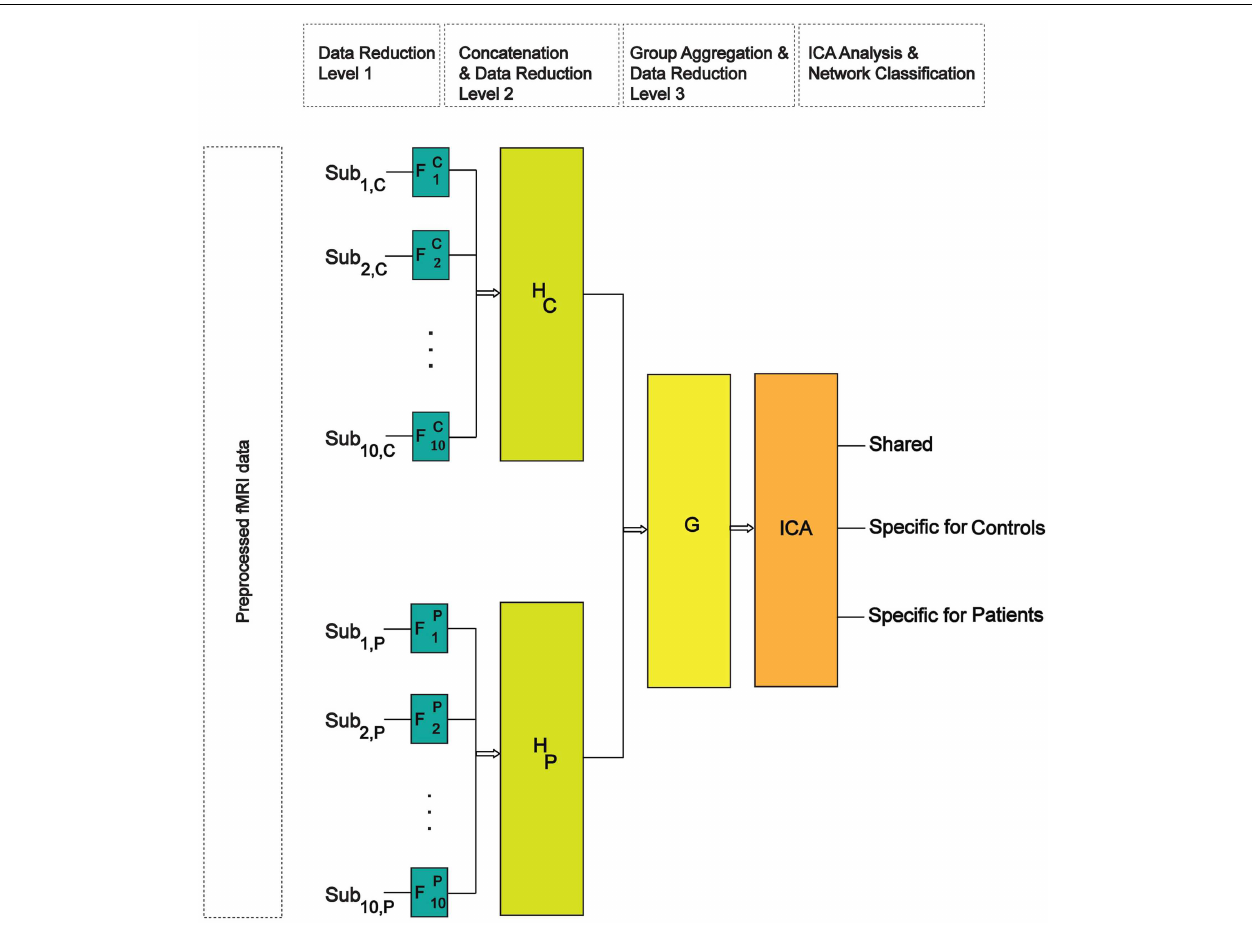
FIGURE 1 | Schematic of the SSICA algorithm .There are three levels of data whitening and reduction. F, H, and G, respectively represent the transformation matrices at the first (subject), second (within-group), and the third (between-group) levels of data